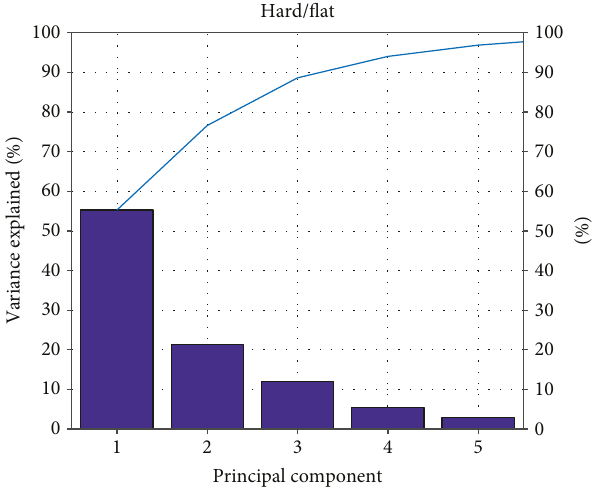
Blue: downhill/hard Red: uphill/hard Green: hard/flat Black: Figure 12: The four ground features are described by the fi rst three principal